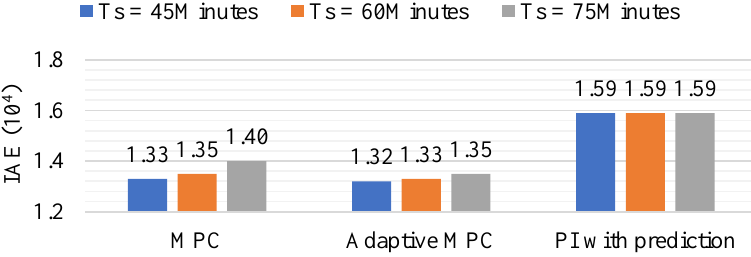
Figure 16. The effect of a variable sampling time (60 ± 15 min) on the controller performance. Results taken as an average of five runs and error bars (red) included to show the variation in IAE.